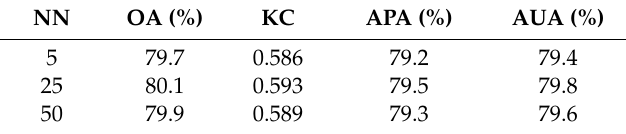
Table 2. Twenty repeated tests of SAMENN ‐ SUIM for Wuhan. Table 3. E ff ects of the neuron number (NN) of hidden layer in SAMENN-SUIM for Wuhan.